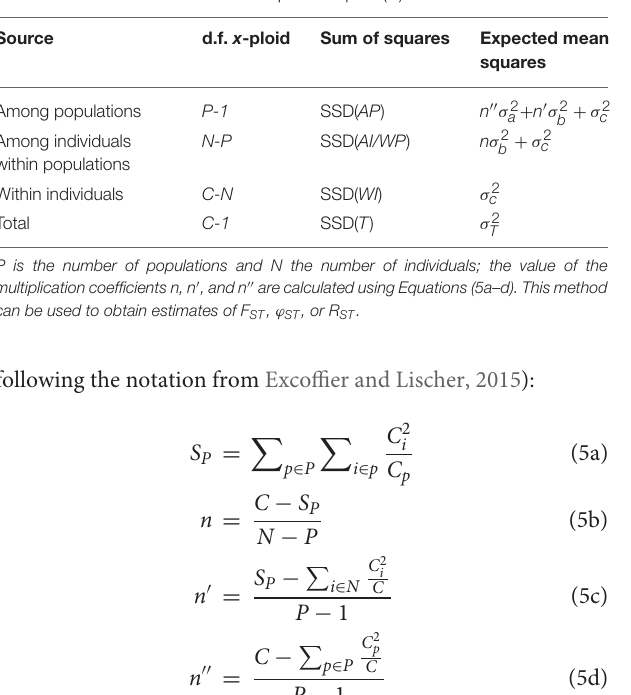
TABLE 3 | Outline of the AMOVA framework for a single group of populations with the degrees of freedom (d.f.) for a mixture of individuals with different ploidy levels, based on the total number of allele copies sampled ( C